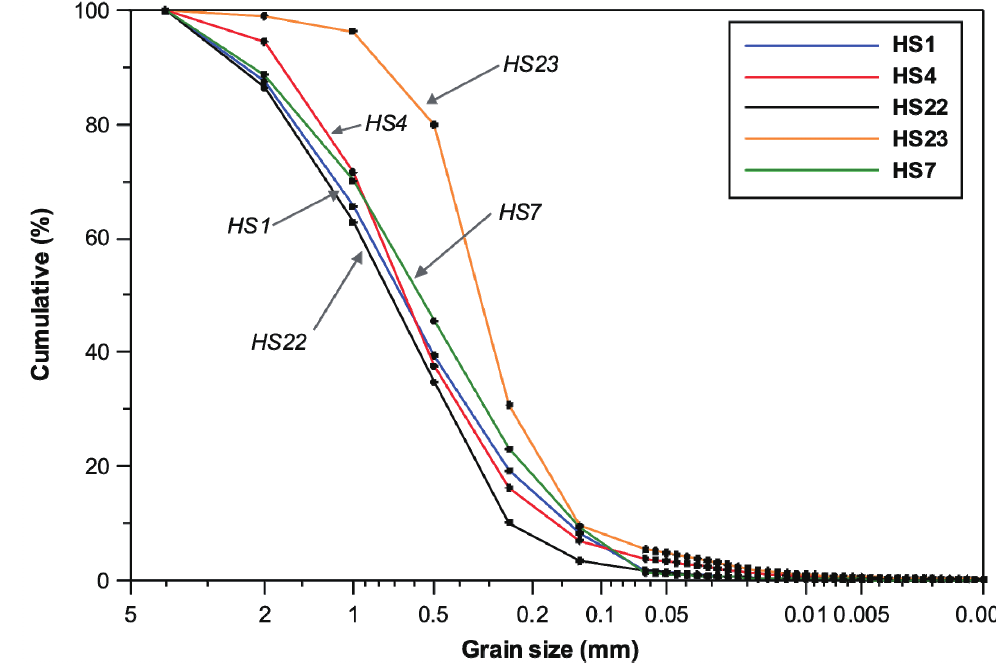
Figure 3. Results of grain size analysis of streambed sediments.